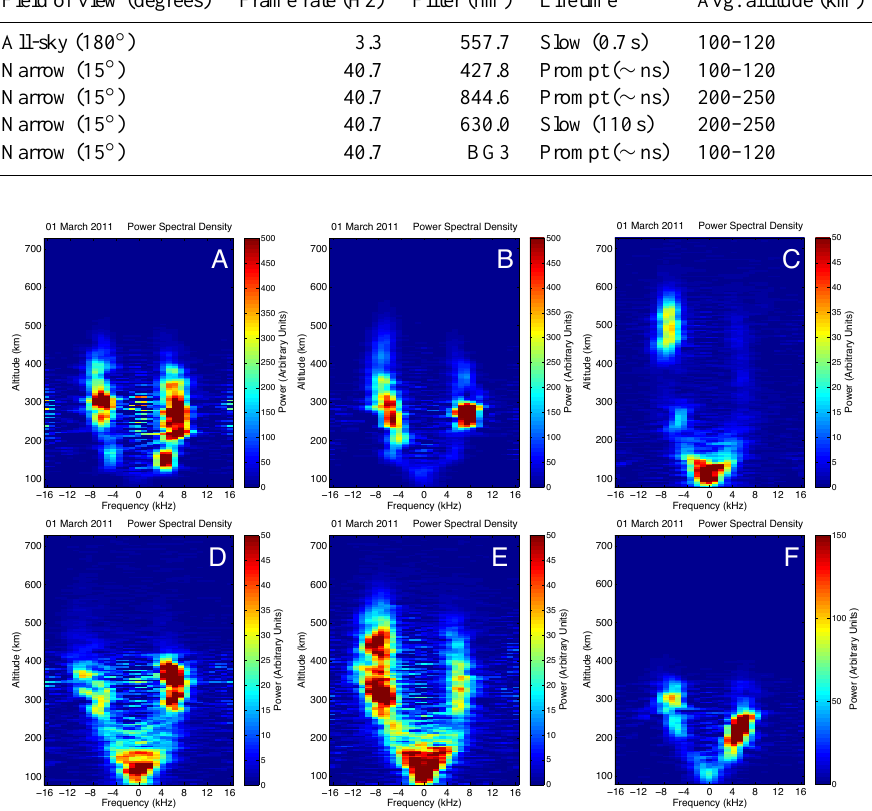
Figure 2. Event 1: NEIAL spectra from the times labeled A–F in Fig. 1. There is a large variation in the spectral features between the 5s integration periods during this event. Overall the downshifted shoulder was more enhanced than the upshifted shoulder. Note that the intensity scale is not the same for each spectrum, due to the extreme variation in NEIAL